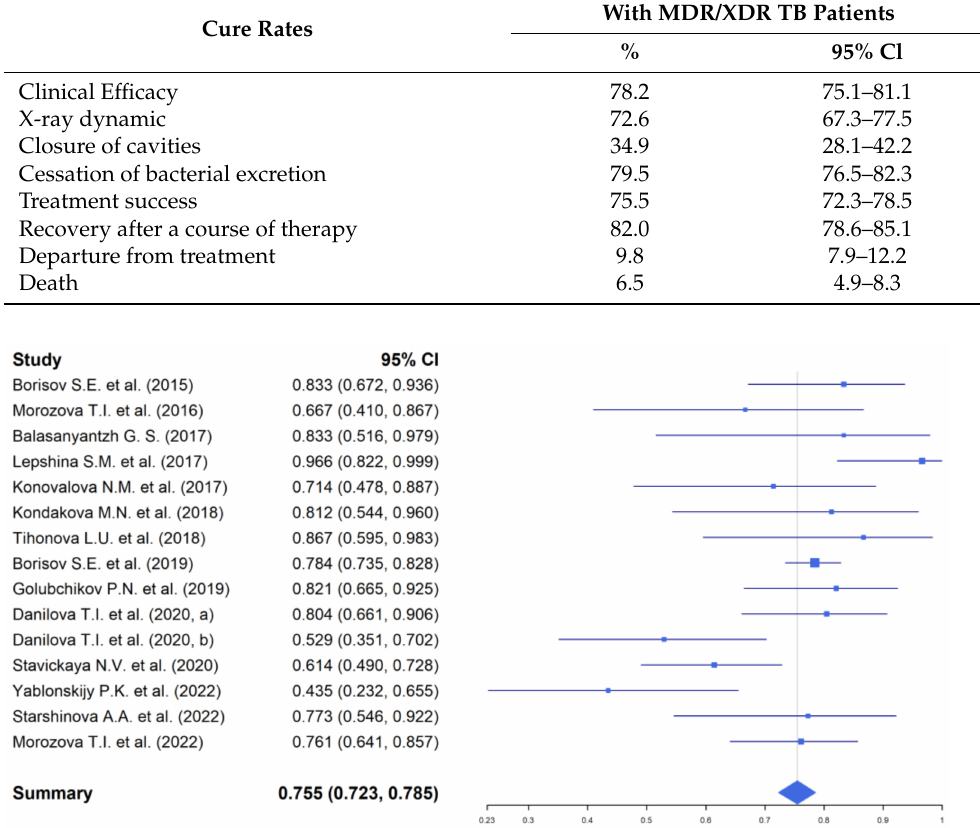
Table 3. Results of treatment of patients with tuberculosis with multiple- and extensive drug- resistance of the pathogen using bedaquiline.